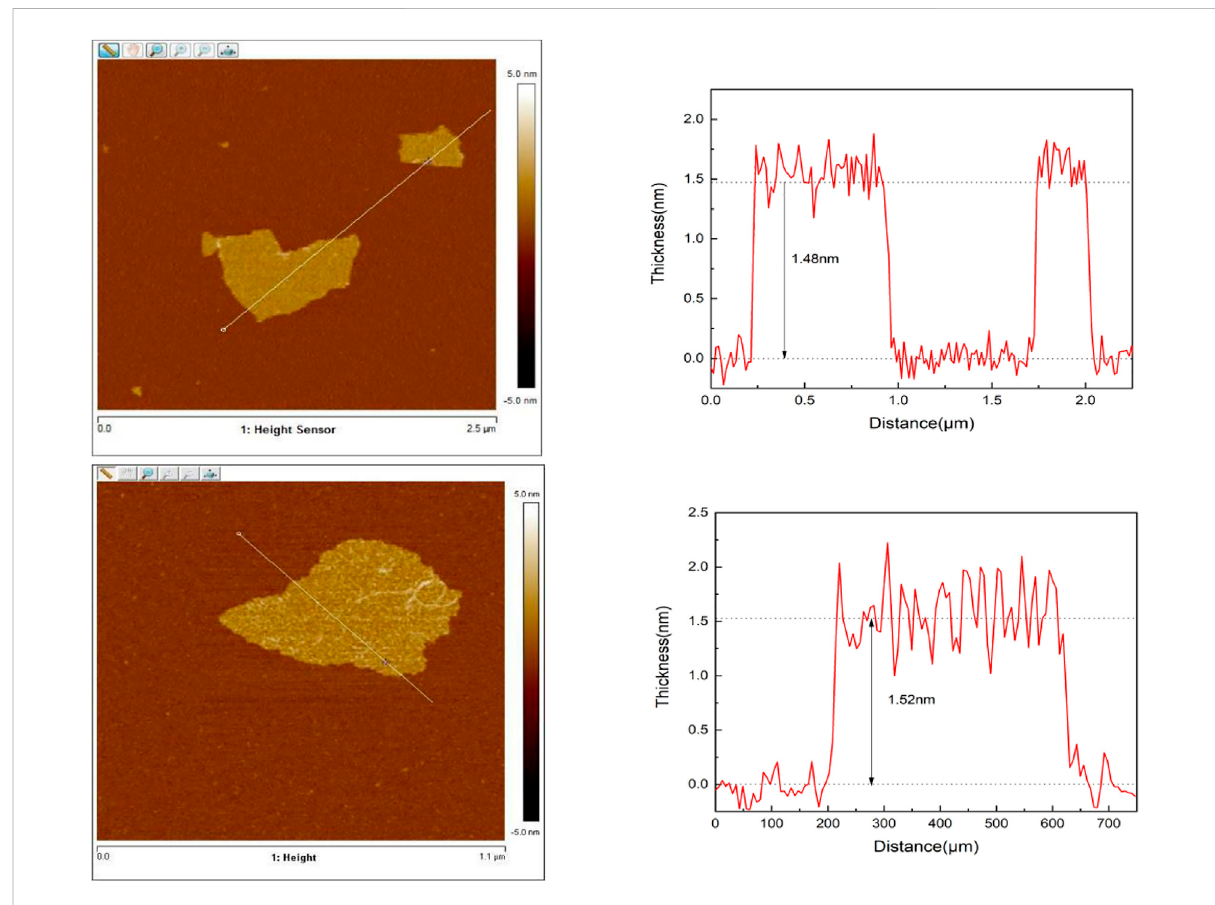
FIGURE 3 AFM spectra of GO and